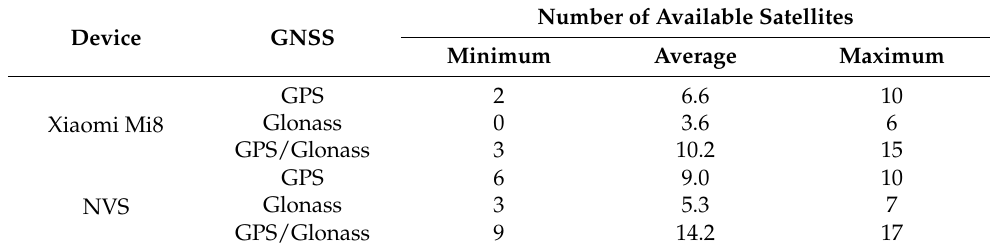
Table 1. Comparison between Xiaomi Mi8 and NVS satellite visibility.